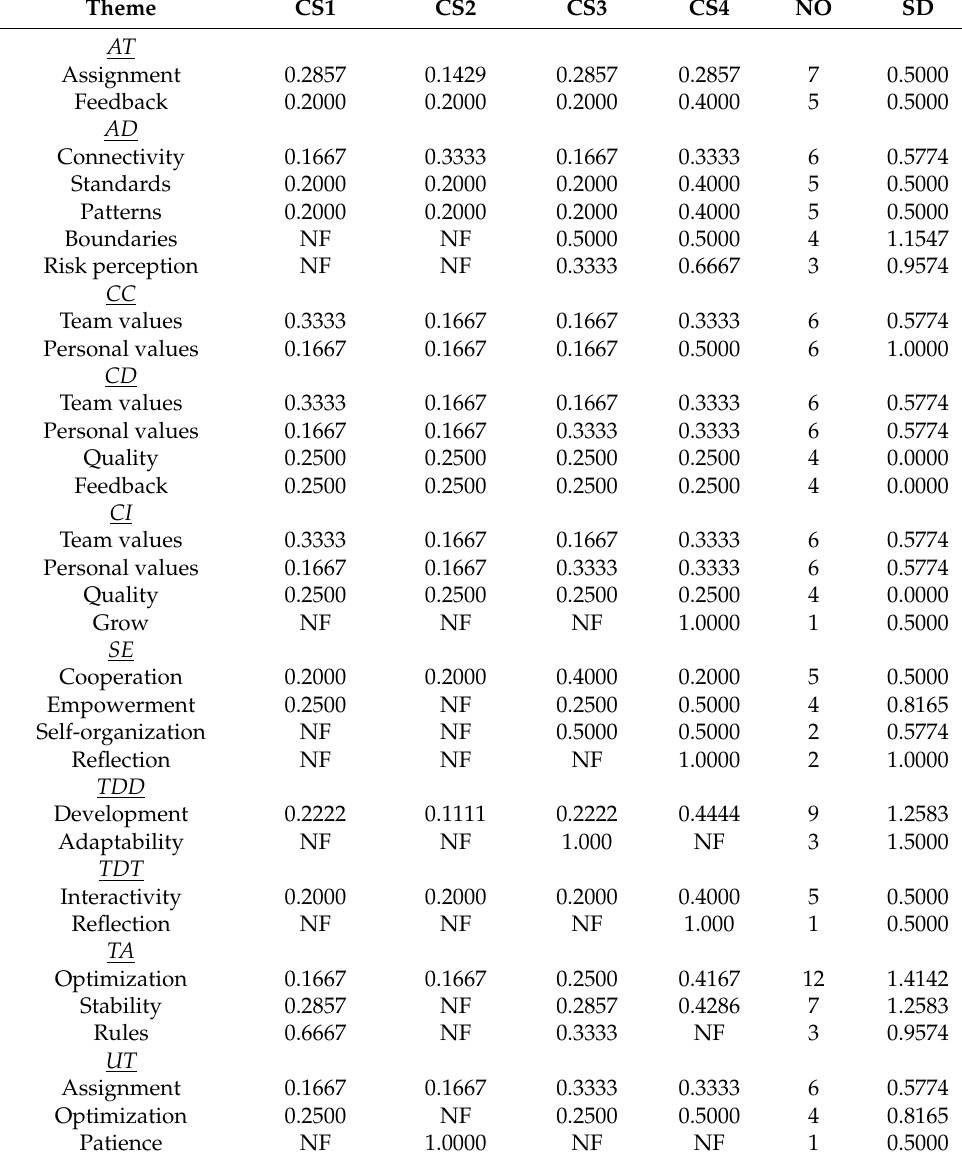
Table 2. Correspondence of final